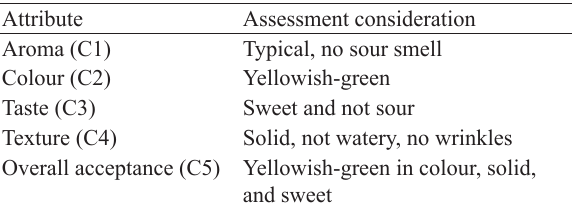
Table 1 Attributes of multi-criteria sensory assessment of Cucumis melo Attribute Assessment consideration